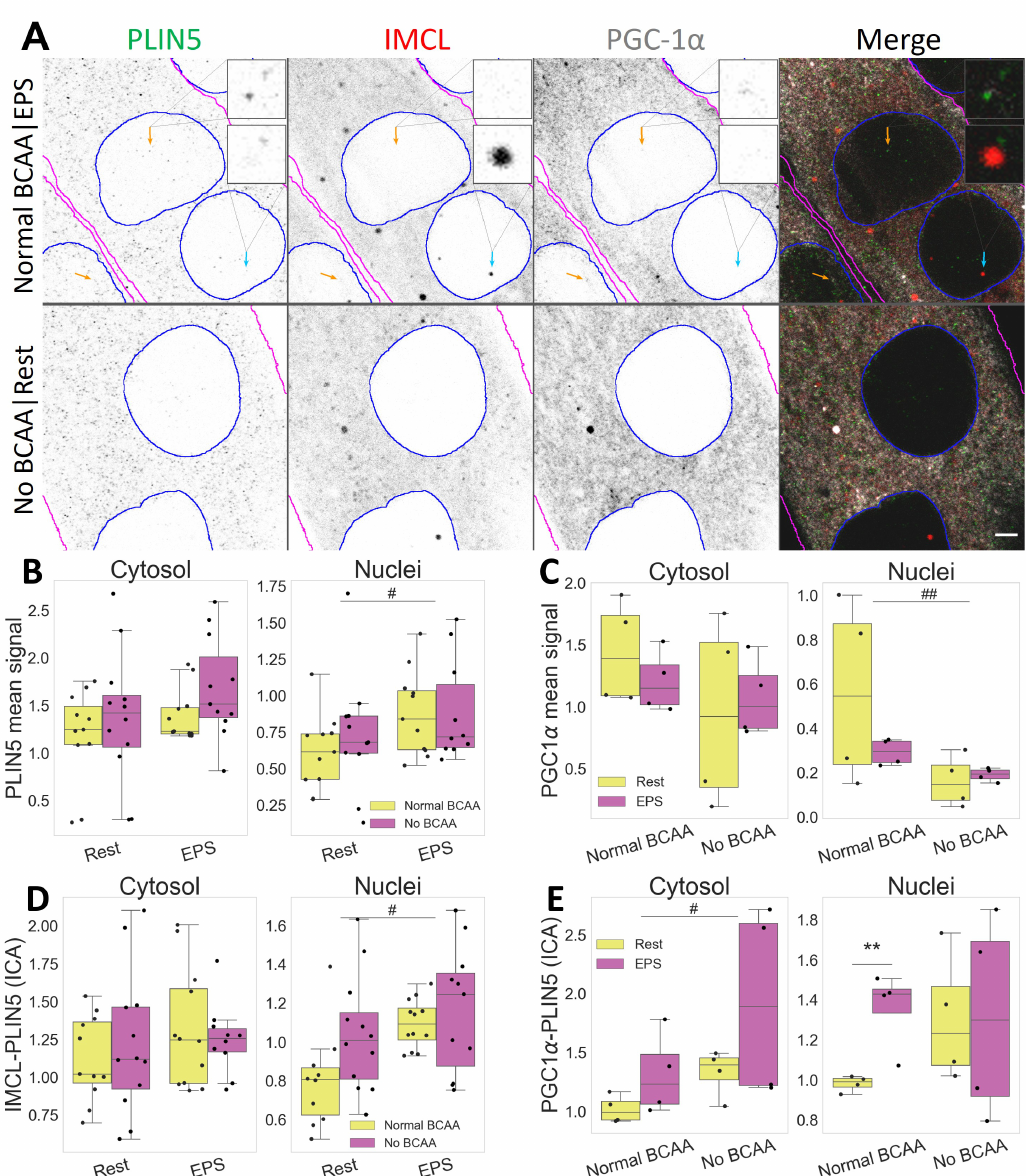
Figure 6. Compartmental association and distribution of PLIN5, IMCL and PGC-1 α after EPS and BCAA deprivation. ( A ) representative image. Note more abundant PLIN5 in nuclei after EPS, with stronger association with PGC-1 α (orange arrows) and IMCL (cyan arrow). Gray is signal, blue are limits of segmented nuclei, magenta are limits of segmented myotubes. Bar = 3 µm; ( B ) PLIN5 signal intensity in different compartments; ( C ) PGC-1 α signal intensity in different compartments; ( D ) ICA between IMCL and PLIN5 in different compartments; ( E ) ICA between PGC-1 α and PLIN5 in different compartments. Main effect differences denoted with # ( p < 0.05) and ## ( p < 0.01). Combined group differences denoted with ** ( p < 0.01). Dots in ( B – E ) represent averaged coverslip values; data normalized to the control group reference (Normal